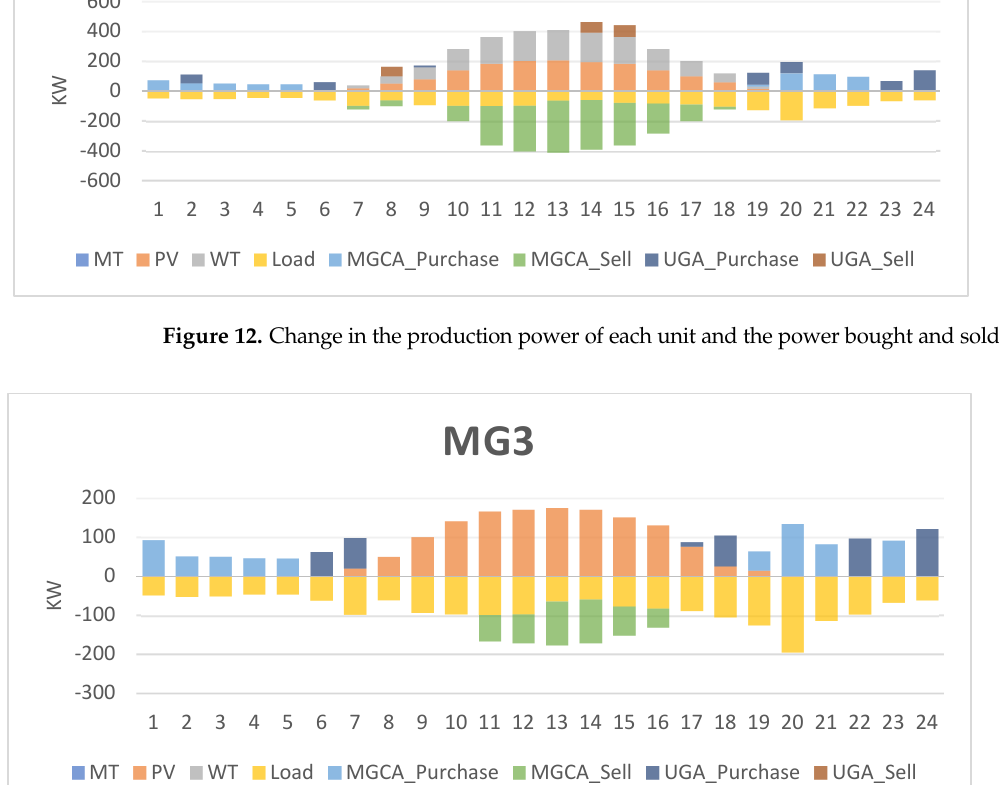
Figure 13. Change in the production power of each unit and the power bought and sold in microgrid 3. Figure 14 shows the total power bought and sold from the microgrid cluster to the microgrids and the upstream network.